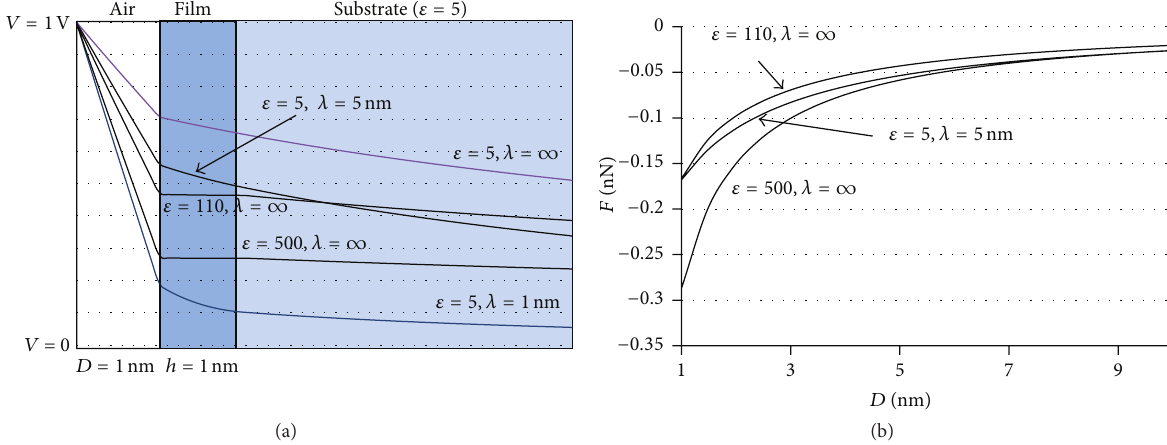
Figure 2: (a) Electrostatic potential drop between the tip apex and the sample for 5 thin film configurations, described in the figure by 𝜀 and 𝜆 . (b) Electrostatic vertical force versus tip-sample distance for three related thin film configurations, where the dielectric constants of the thin films that do not have any conductivity have been adjusted to fit the upper and lower limit of the thin film with 𝜆 = 5 nm. In both figures, = 5 , 𝑉 = 1 V, and ℎ = 1 𝑅 = 20 nm, 𝜀 2 0